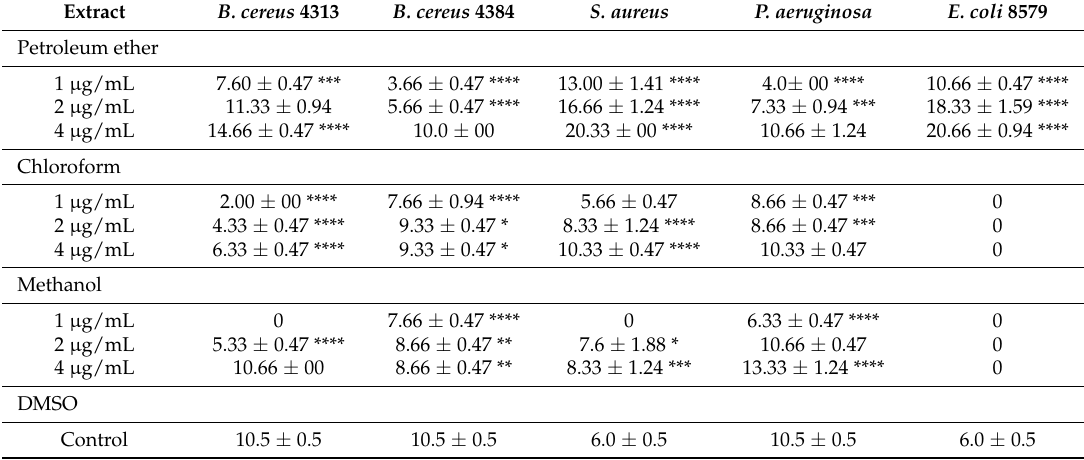
Table 4. Antibacterial activity of petroleum ether, chloroform and methanol extracts of P. aculeata. Extract